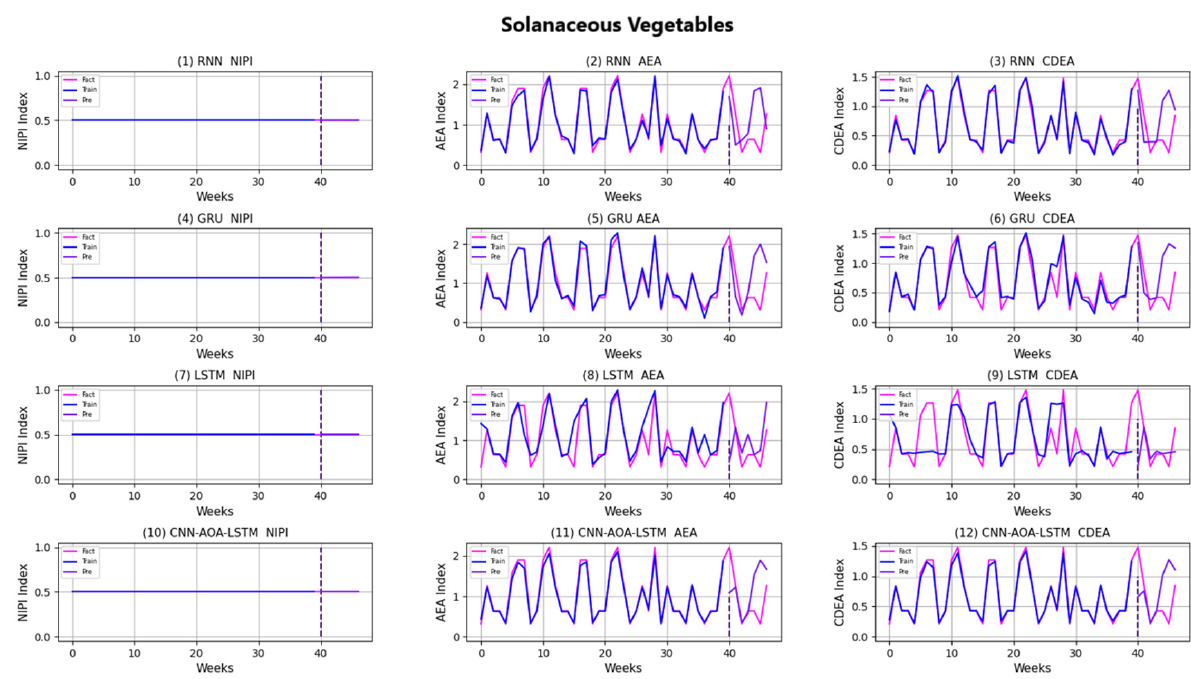
Figure 9. Prediction results of indexes of leafy vegetables.